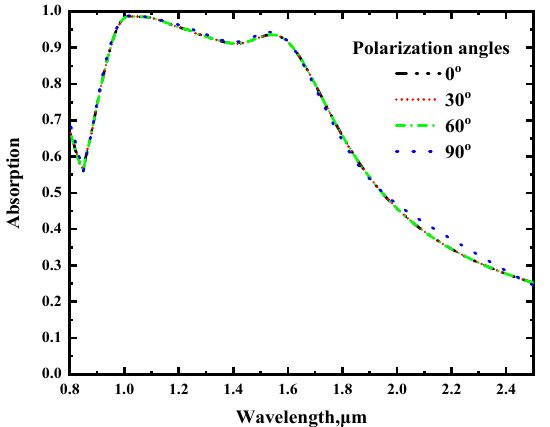
Figure 8. Absorption spectra at different polarization angles.